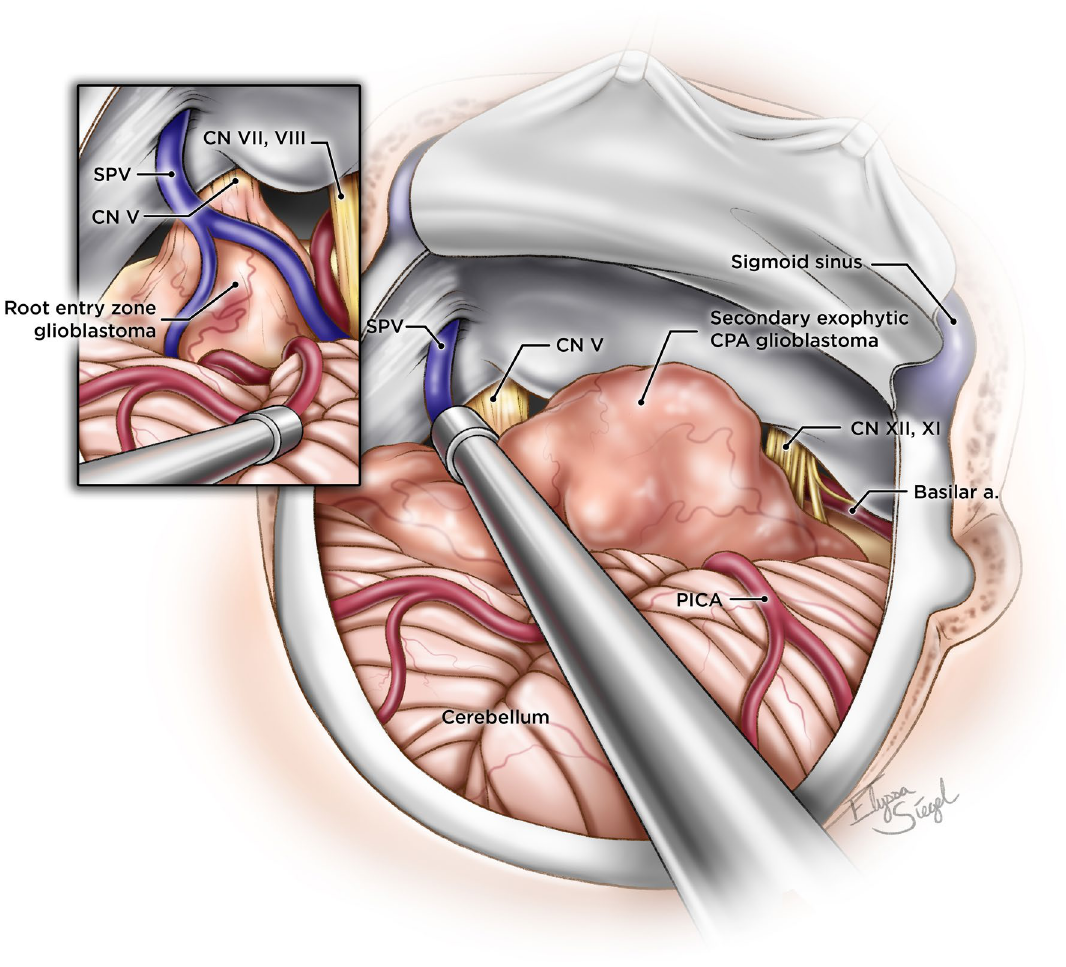
Figure 5. Artist’s illustration of exophytic and nerve REZ (inset) CPA glioblastoma ©Elyssa Siegel